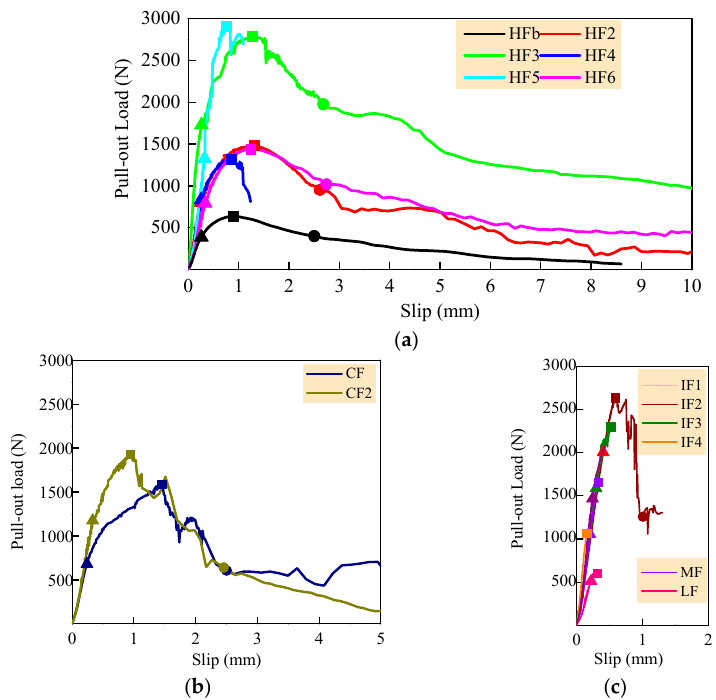
Figure 10. The characteristic pull-out load-slip curves of different deformed steel fibers: ( a ) hooked steel fiber; ( b ) crimped steel fiber; ( c ) steel fibers of indentation, milled, and large-end. Table 5. Key points of pull-out load-slip curves.